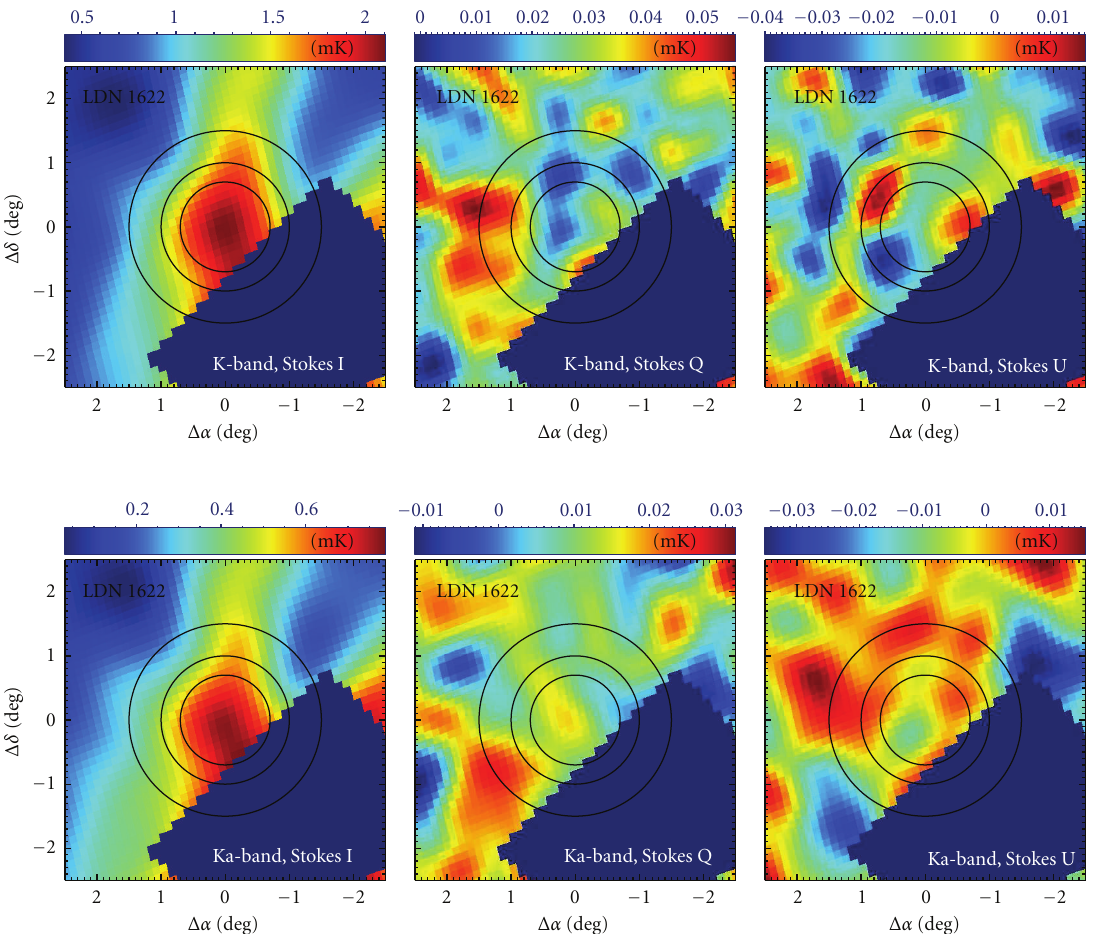
Figure 3: The LDN1622 region, as seen by WMAP in Stokes parameters I (left), Q (centre), and U (right column), at 23 GHz (top row) and 33GHz (bottom row). All maps are displayed at the common angular resolution of 1 . 0 ◦ . The circles ( r 0 = 0 . 7 ◦ , r 1 = 1 . 0 ◦ , and r 2 = 1 . 5 ◦ ) indicate the main aperture ( r 0 ) and the region for the background correction ( r 1 < r < r 2 ) used for the aperture photometry method. The masked regions are not included in the flux density determination (see text for details).